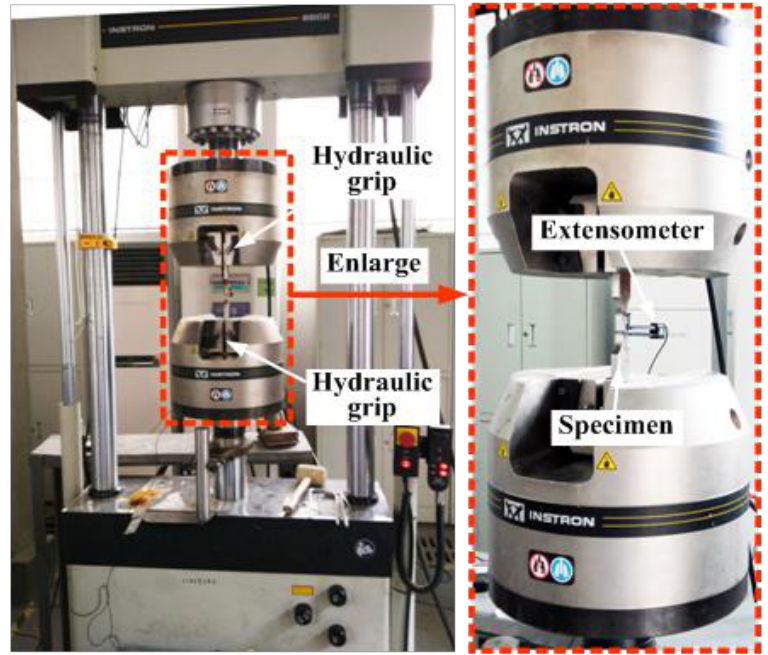
Figure 2. Test setup and instrumentation.